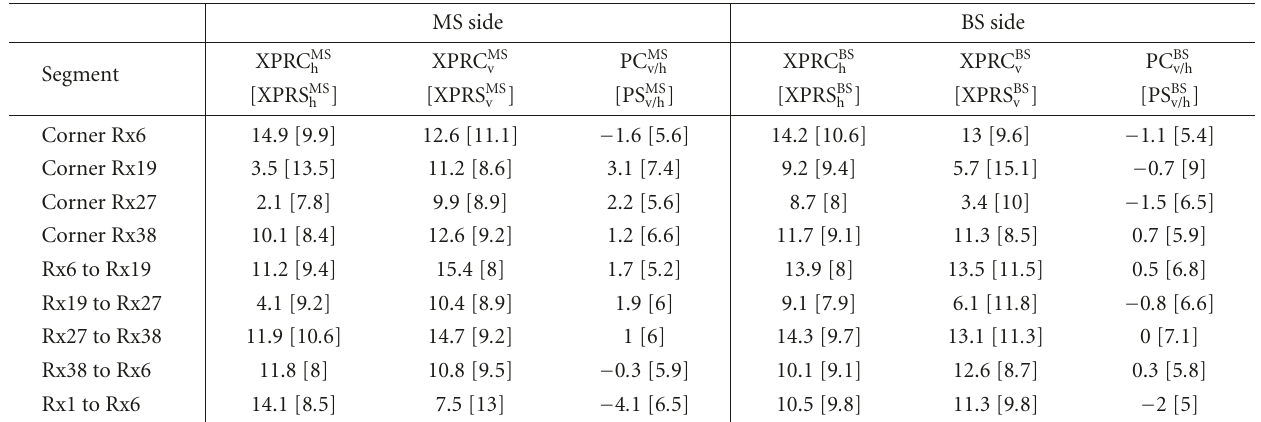
Table 3: XPRC and XPRS of the SCs in dB.